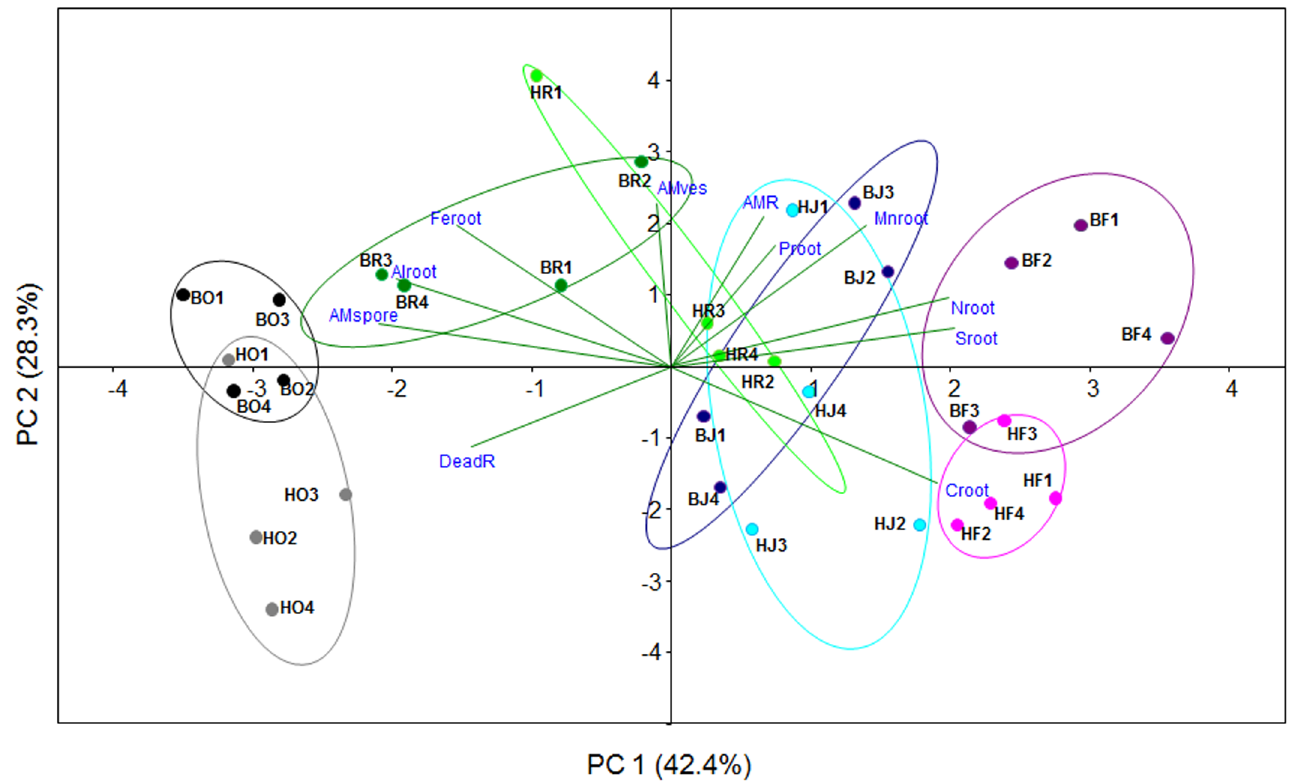
Fig 4. Principle component analysis of root community-weighed traits. The traits used for PCA and their abbreviations are listed in Table 2. B = Bukit 12, H = Harapan, O = oil palm, R = rubber plantation, J = jungle rubber, F = forest.